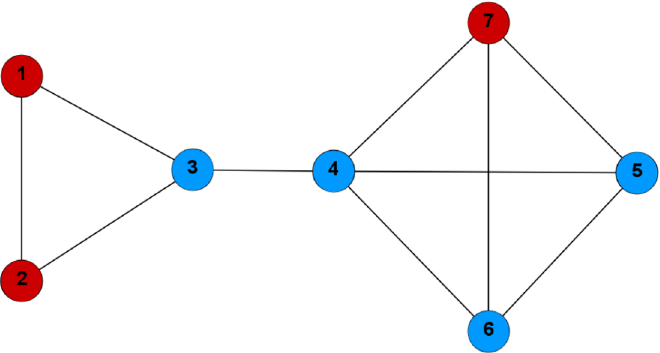
¼ f 1 ; 2 ; 7 g (red), C 0 ¼ f 3 ; 4 ; 5 ; 6 g (blue) form the strategy profile q = (1, 1, 2, 1 2